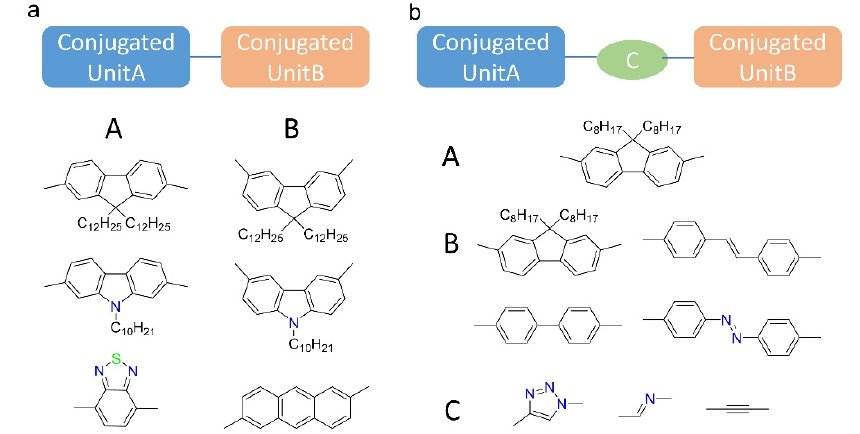
Figure 6. Polymer libraries established to study the e ff ect of backbone structures on the dispersion selectivity. ( a ) Schematic diagram for partial copolymers with di ff erent monomer attachment sites. Those contain (9,9-dialkyl-2,7-fluorene) have better conjugate e ff ect and dispersing selectivity; ( b ) polymer library of 9,9-dioctylfluorene derivatives employing biphenyle, stilbene, azobenzene